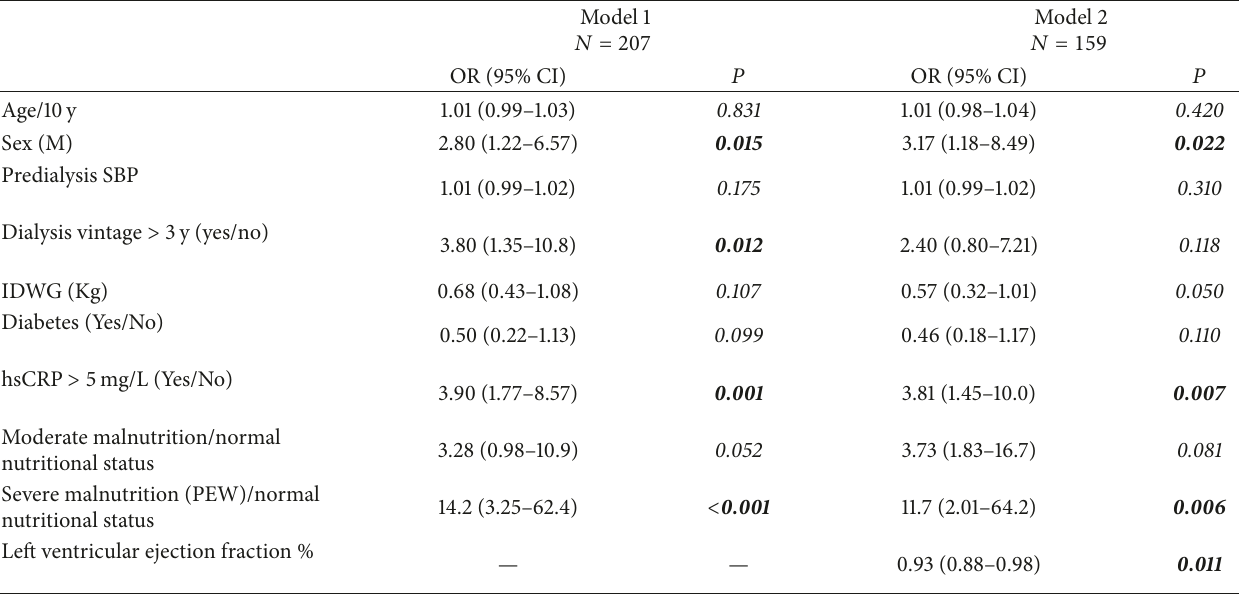
Table 3: Multivariate logistic regression for high values of NT-proBNP ( ≥ 6243